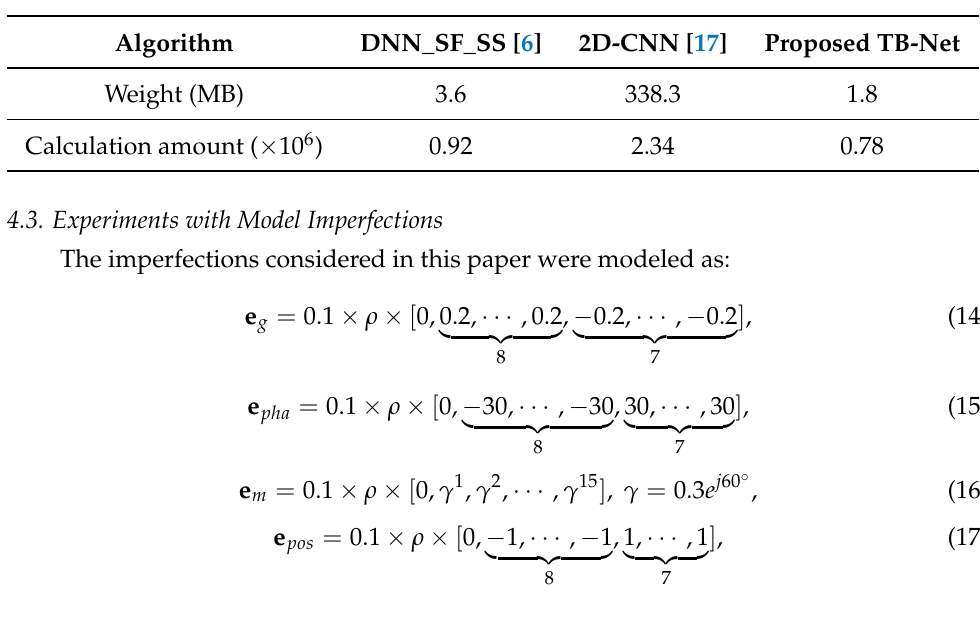
Table 2. Computational complexity